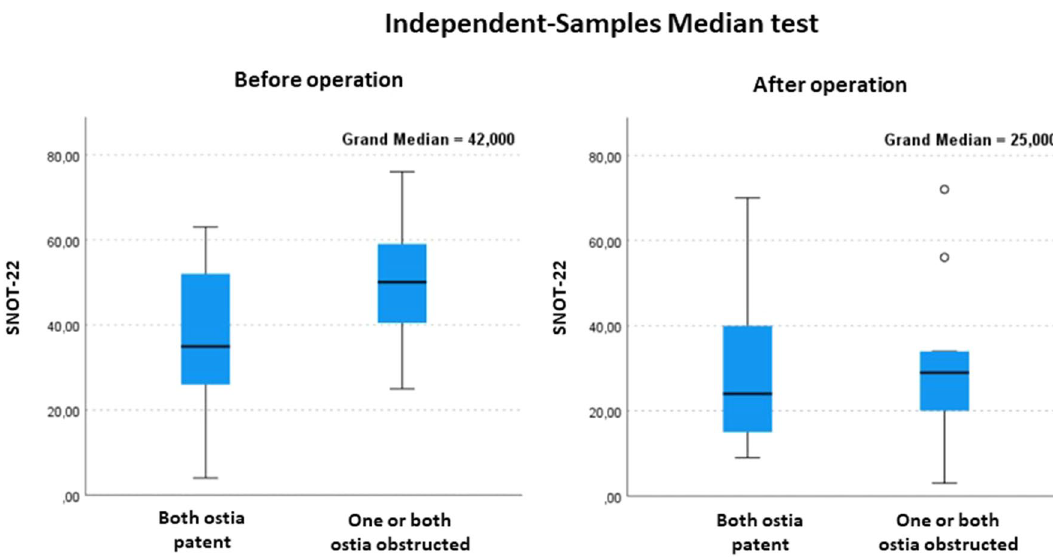
Figure 2. SNOT-22 scoring before and after balloon sinuplasty by Mann–Whitney